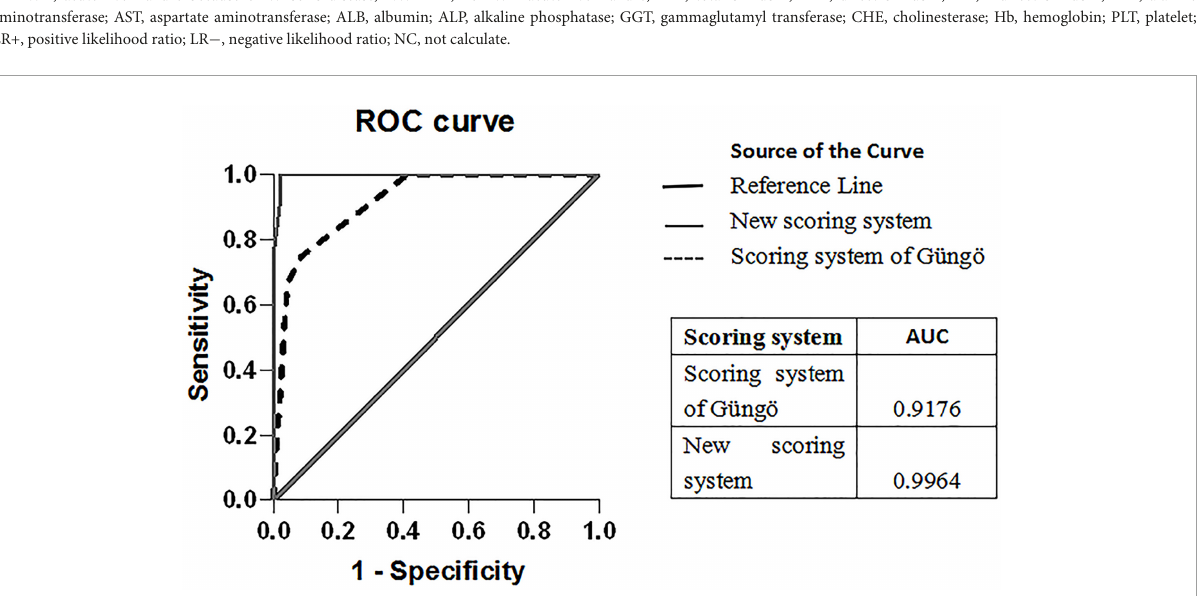
analysis of Güngö et al. (11) and our scoring system is shown in Figure 2